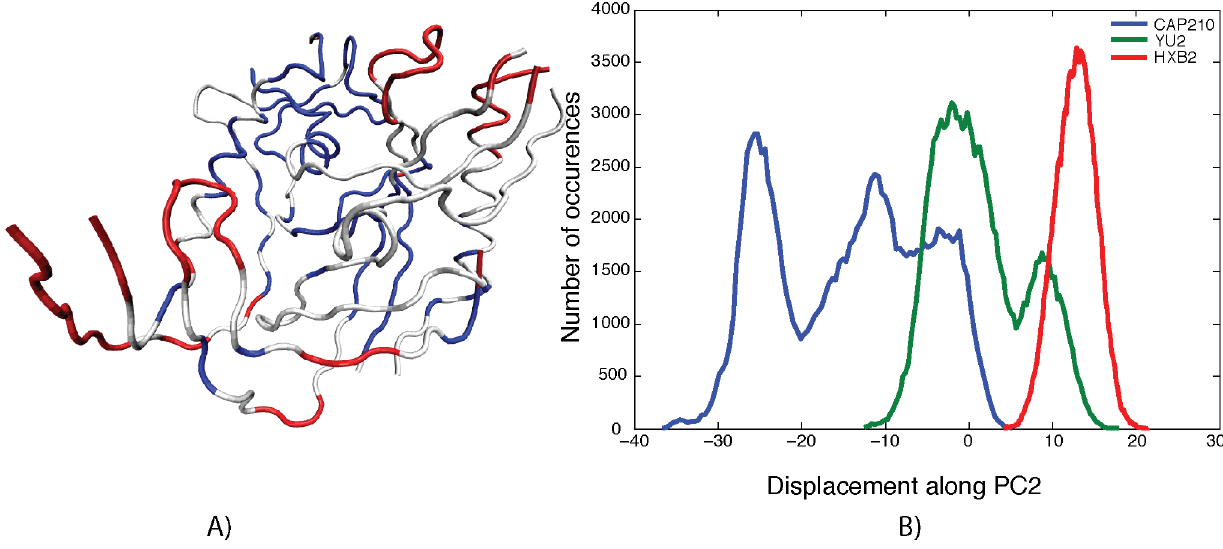
Figure 3. The coupling of motion along PC2 (A). Colors are as defined in Figure 4. The histogram of displacement along PC2 for each simulation is shown in (B).